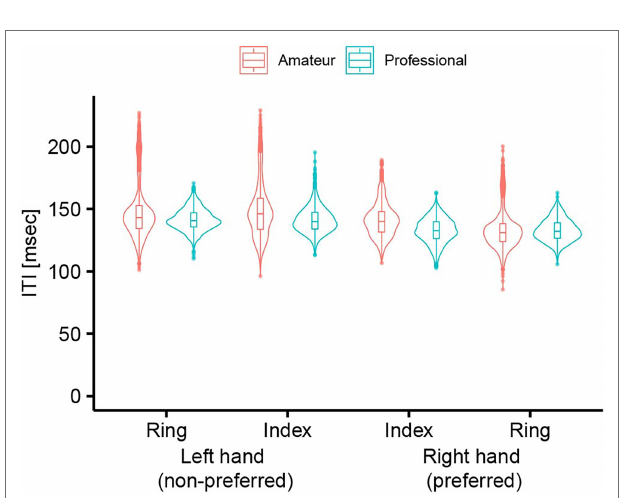
FIGURE 4 | Inter-tap interval of professional and amateur darbuka players in the single-finger tapping task ( n = 8 for the professional group and n = 8 for the amateur